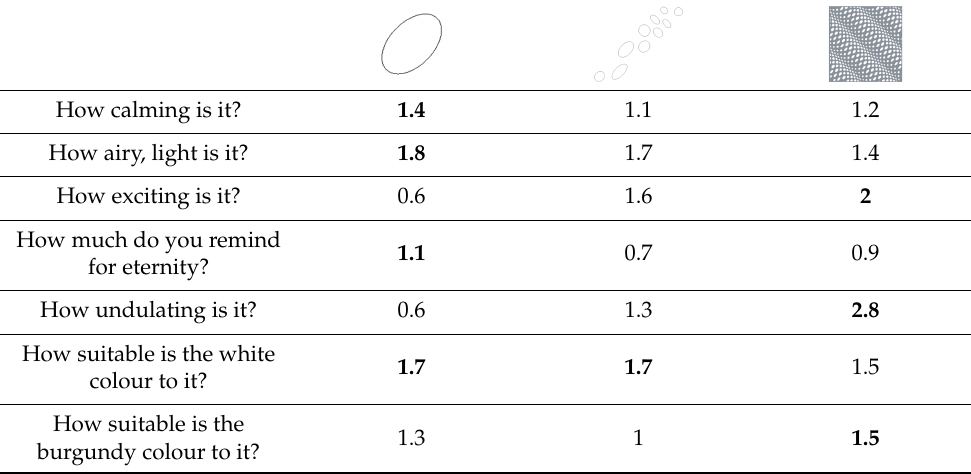
Table 6. First pattern—node